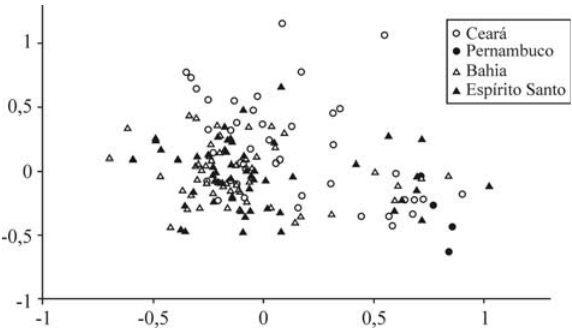
Figure 4 - Correspondence factorial analysis of allozyme